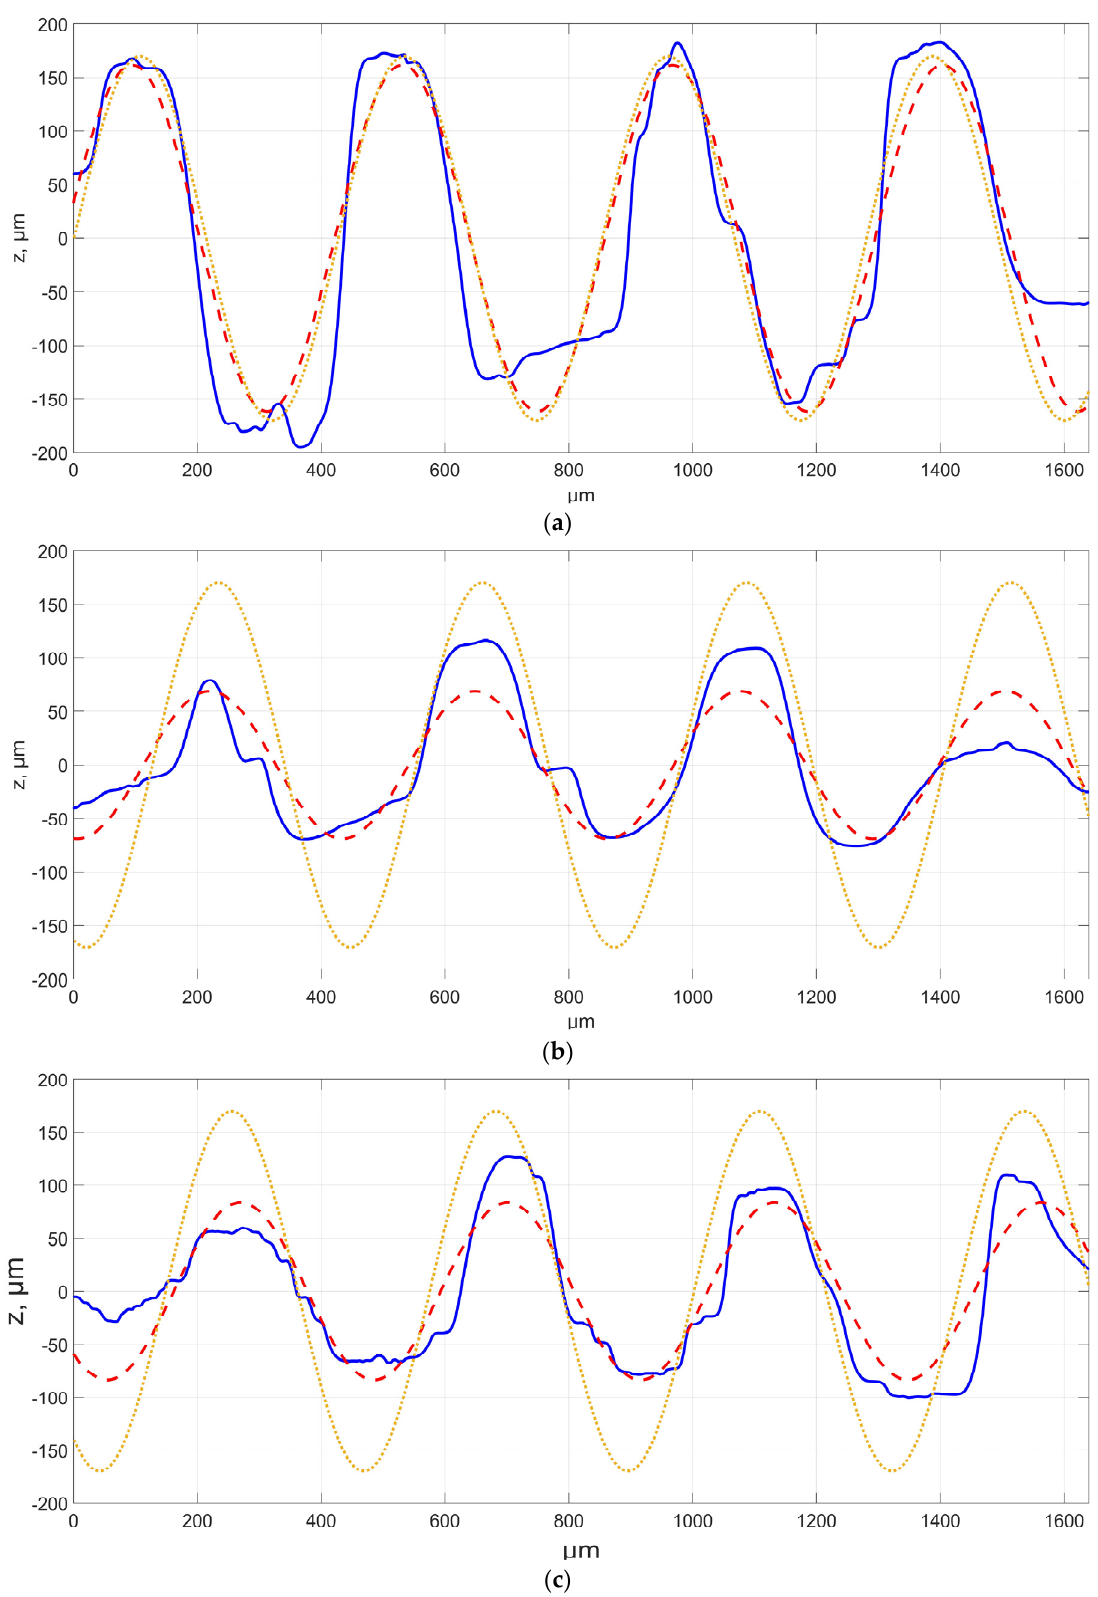
Figure 3. Example of a surface profile for samples No. 1–3 with an approximating function, respec- tively, as a function of building angle ( a ) 20 ◦ , ( b ) 45 ◦ , ( c ) 70 ◦ . The blue color indicates the measured profile, the red color indicates approximation, and the green color indicates the CAD